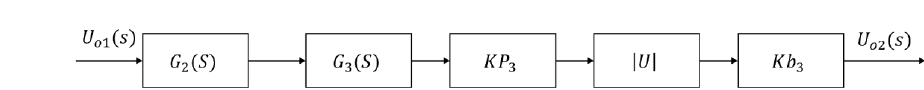
Figure 4. EMG sensor: acquisition module.